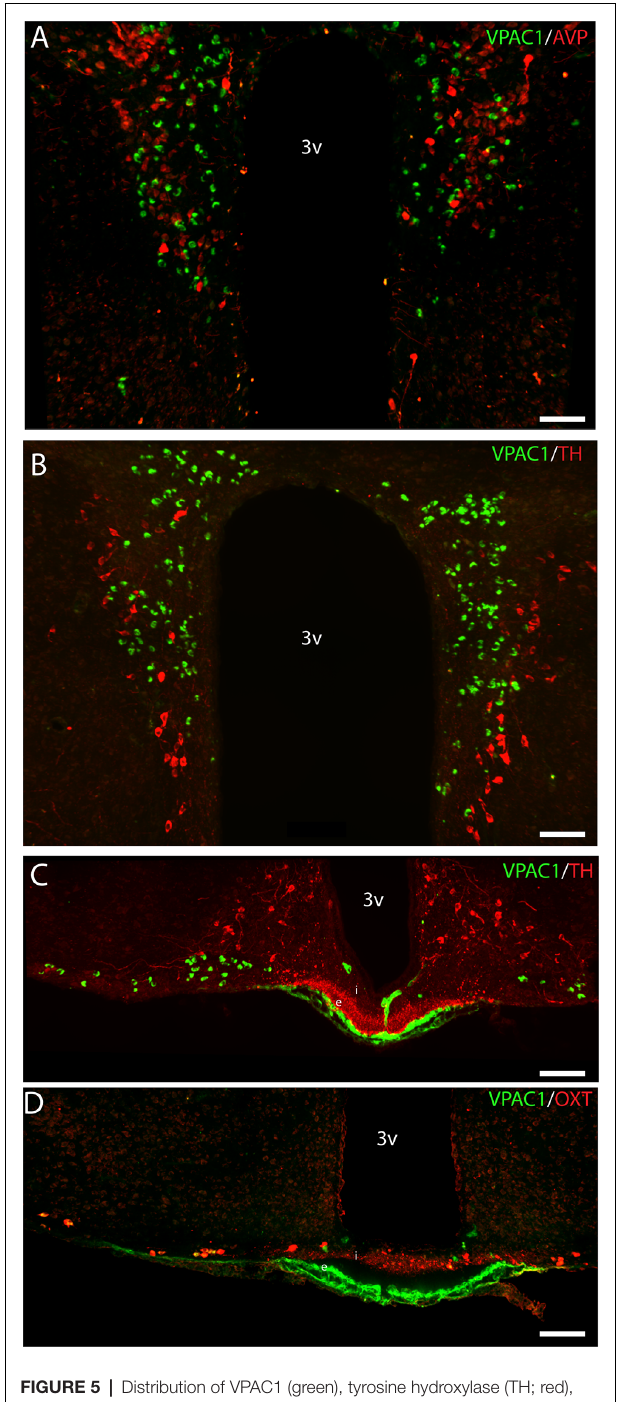
FIGURE 5 | Distribution of VPAC1 (green), tyrosine hydroxylase (TH; red), OXT (red), and AVP (red) in the PVN and median eminence (ME). VPAC1 (green), TH (red), and AVP (red) immunoreactivity were found in the PVN (A,B) showing no colocalization. TH (red) was found in the external layer of the ME (C) , whereas OXT (red) was found in the internal layer (D) . VPAC1 (green) immunoreactivity was seen in relations to the portal blood vessel (C,D) , as an indicator of VPAC1 expression on the smooth muscle cells of the cerebral blood vessels but was not colocalized with TH or OXT neurons in the ME. Images (A–D) represent maximal projections of 16 digital sections in a Z -stack ( Z = 2 µ m). Scale bars: (A,B) = 80 µ m; (C,D) = 100 µ